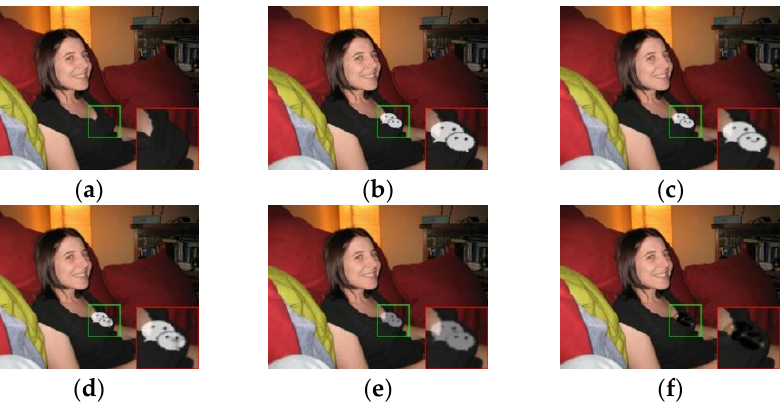
Figure 6. Visual effects of different methods with a transparency rate of 0.8 for image watermark removal. ( a ) Original image, ( b ) watermark image, ( c ) DnCNN, ( d ) FFDNet, ( e ) U-net and ( f ) IWRU-net (ours).